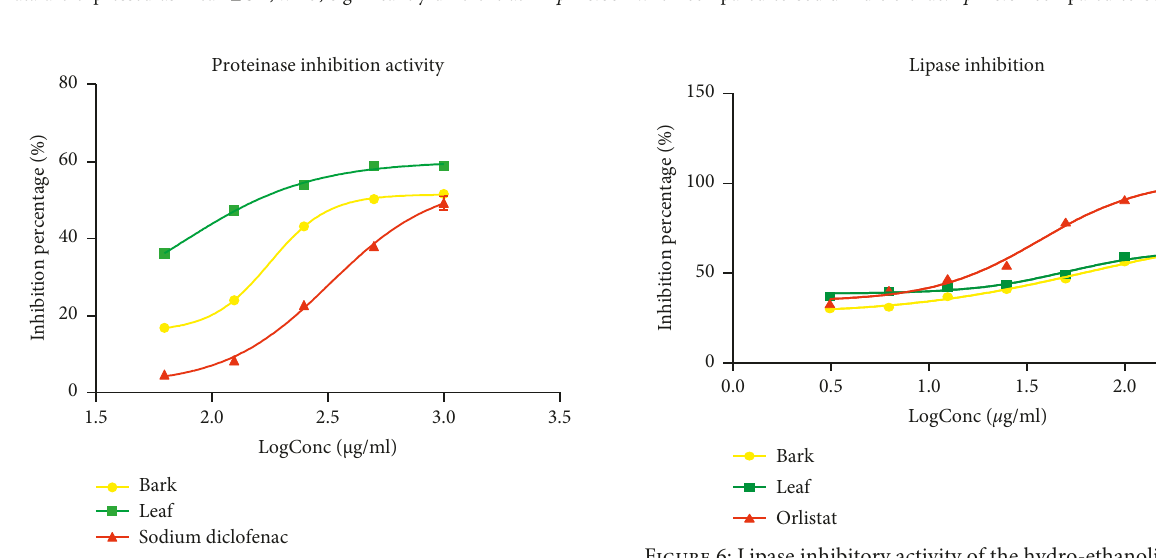
Figure 5: Antiproteinase activity of the hydro-ethanolic leaf and bark extracts of Psychotria densinervia and sodium diclofenac. Values are expressed as mean ± SD ( n � 3).